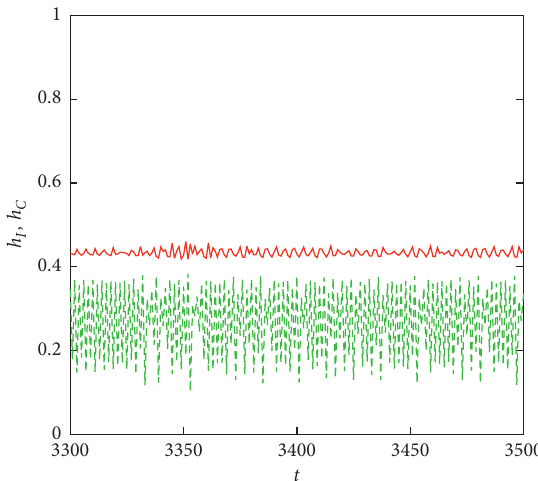
Figure 6: Cluster h C (green line) and incoherent contributions to the mean field of system equations (7) and (9), as functions of time. Fixed parameters b � 0 . 5 and ε � 0 . 19, and size N � 10 4